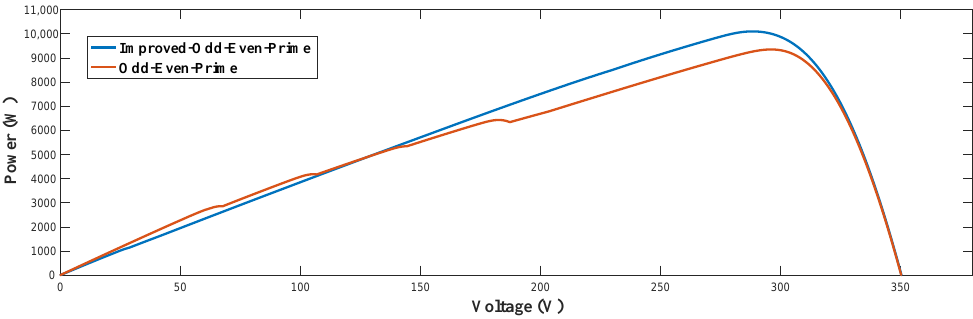
Figure 19. Voltage–power characteristics of 8 × 9 PV array for case-2 (Top-Right) PSC.